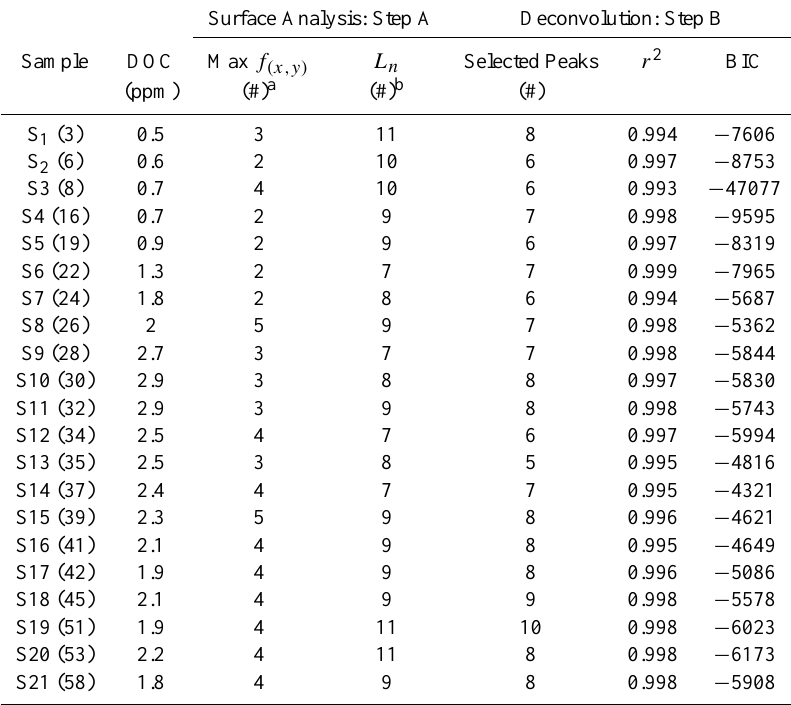
Table 1. DOC concentration and deconvolution results for each DOM sample. The number of initial potential peaks (step A) and selected peaks after step B, goodness-of-fit parameters ( r 2 and BIC) of each optimal FDM model are provided. Numbers in parenthesis in the first column show the distance (km) of each sampling point from the